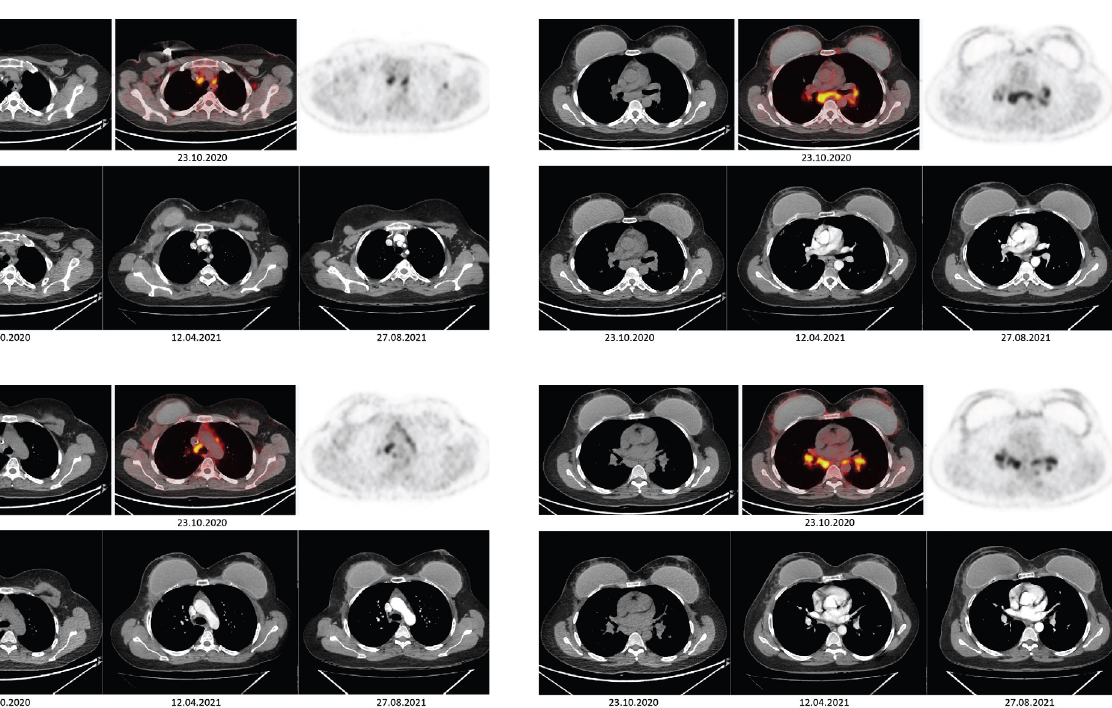
Figure 1. Computed tomography +